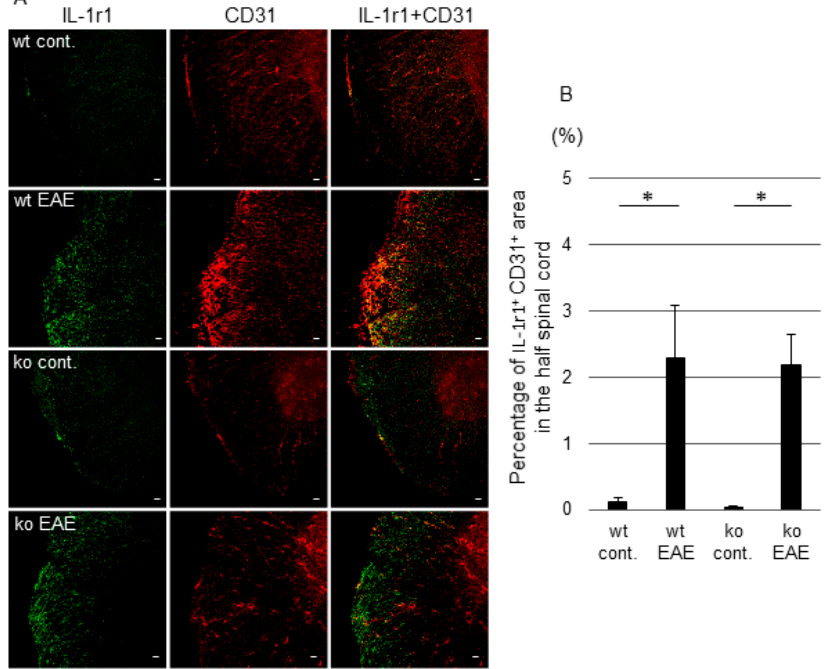
Figure 7. Expression of IL-1 receptor 1 (IL-1R1) in CD31-positive (CD31 + ) endothelial cells (ECs) in the spinal cords of control and experimental autoimmune encephalomyelitis (EAE) mice. Immunohistochemical images showing IL-1R1 (green) and CD31 (red) in the spinal cords of wild-type (wt) control, wt EAE, microsomal PGE synthase-1 ( mPGES-1 ) − / − control, and mPGES-1 − / − EAE mice ( A ). Percentage of the IL-1R1-positive (IL-1R1 + ) CD31 + area in half of the spinal cord per half of the spinal cord area ( B ). Scale bars are 20 µ m; wt, wild-type; ko, mPGES-1 − / − ; cont., naïve mice; EAE, EAE mice. * p < 0.05.